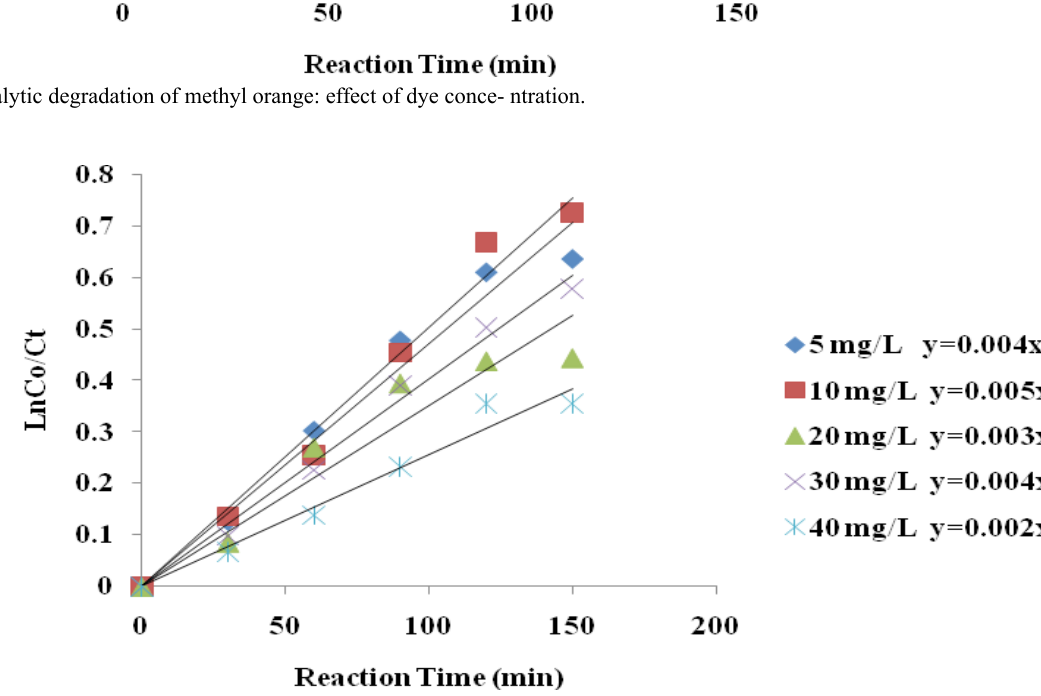
Fig. 6. Plot of Ln (C